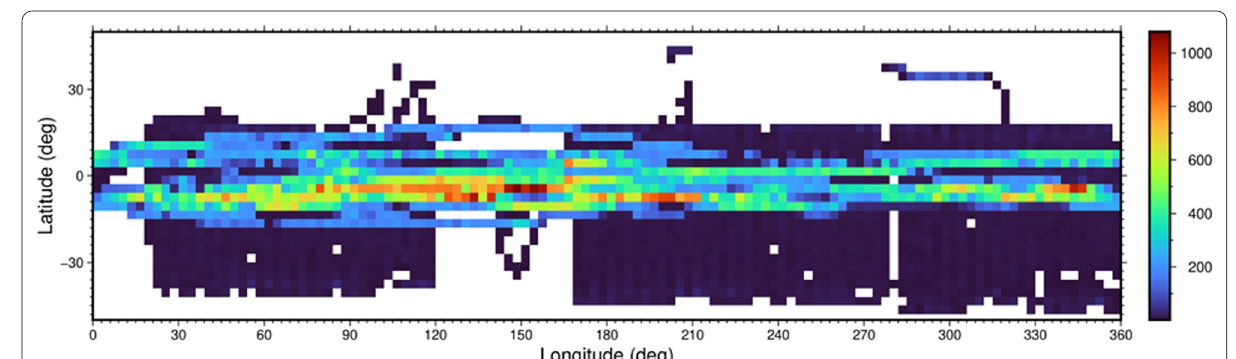
Fig. 14 Map of the number of footprints in each 3°-by-3° grid. Empty grids are shown in white